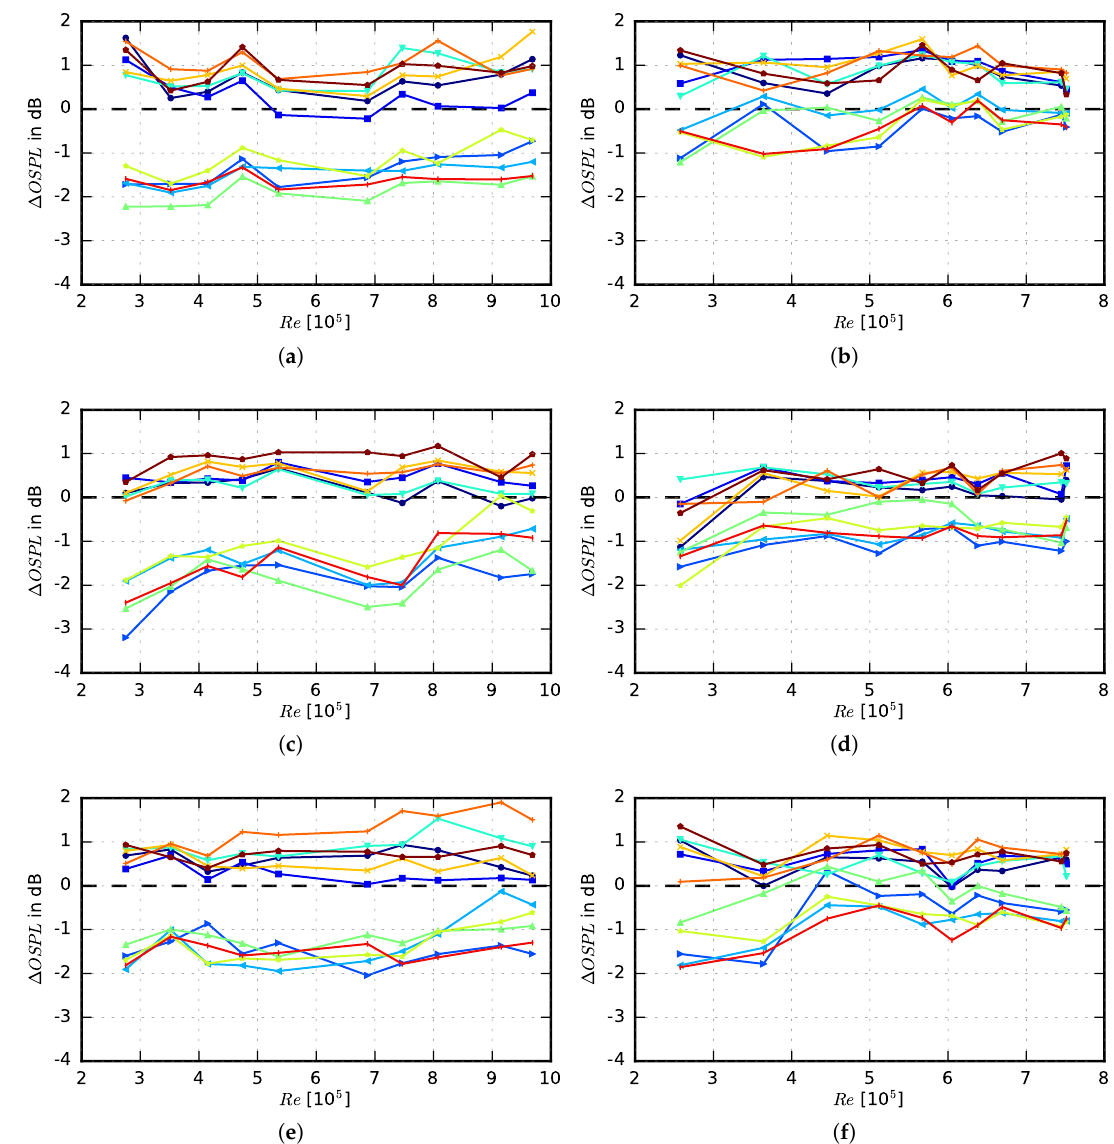
Figure 9. Difference of overall sound pressure level according to Equations (2) and (3) (airfoil 1, 2, 3, 4, 5, 6, 7, 8, 9, 10, 11; positive values denote a noise reduction due to the modifications, negative values a noise increase), ( a ) PPS 12/2, α = 0 ◦ , ( b ) PPS 14/4, α = 0 ◦ , ( c ) PPS 12/2, α = 6 ◦ , ( d ) PPS 14/4, α = 6 ◦ , ( e ) PPS 12/2, α = 12 ◦ , ( f ) PPS 14/4, α = 12 ◦